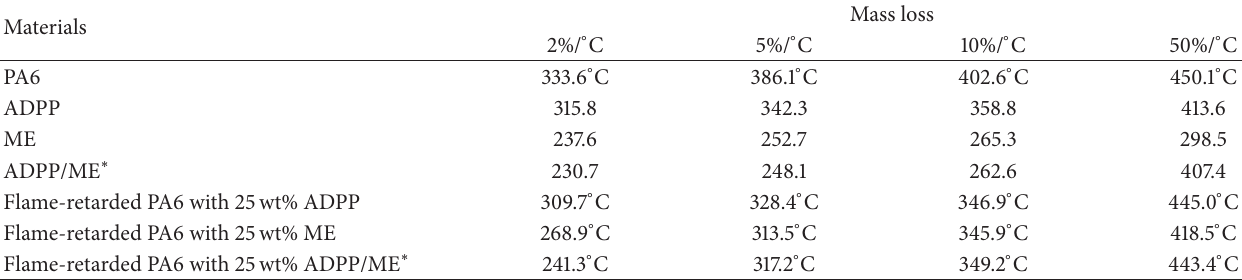
Table 3: Thermogravimetric results.